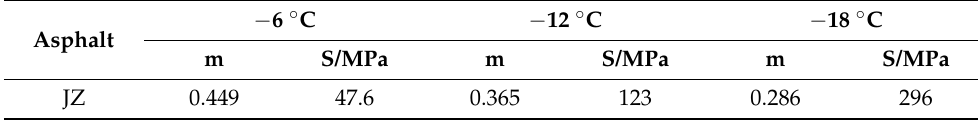
Figure 16. The effects of short-term aging on rutting factor. Table 11. Low temperature bending test results of JZ.